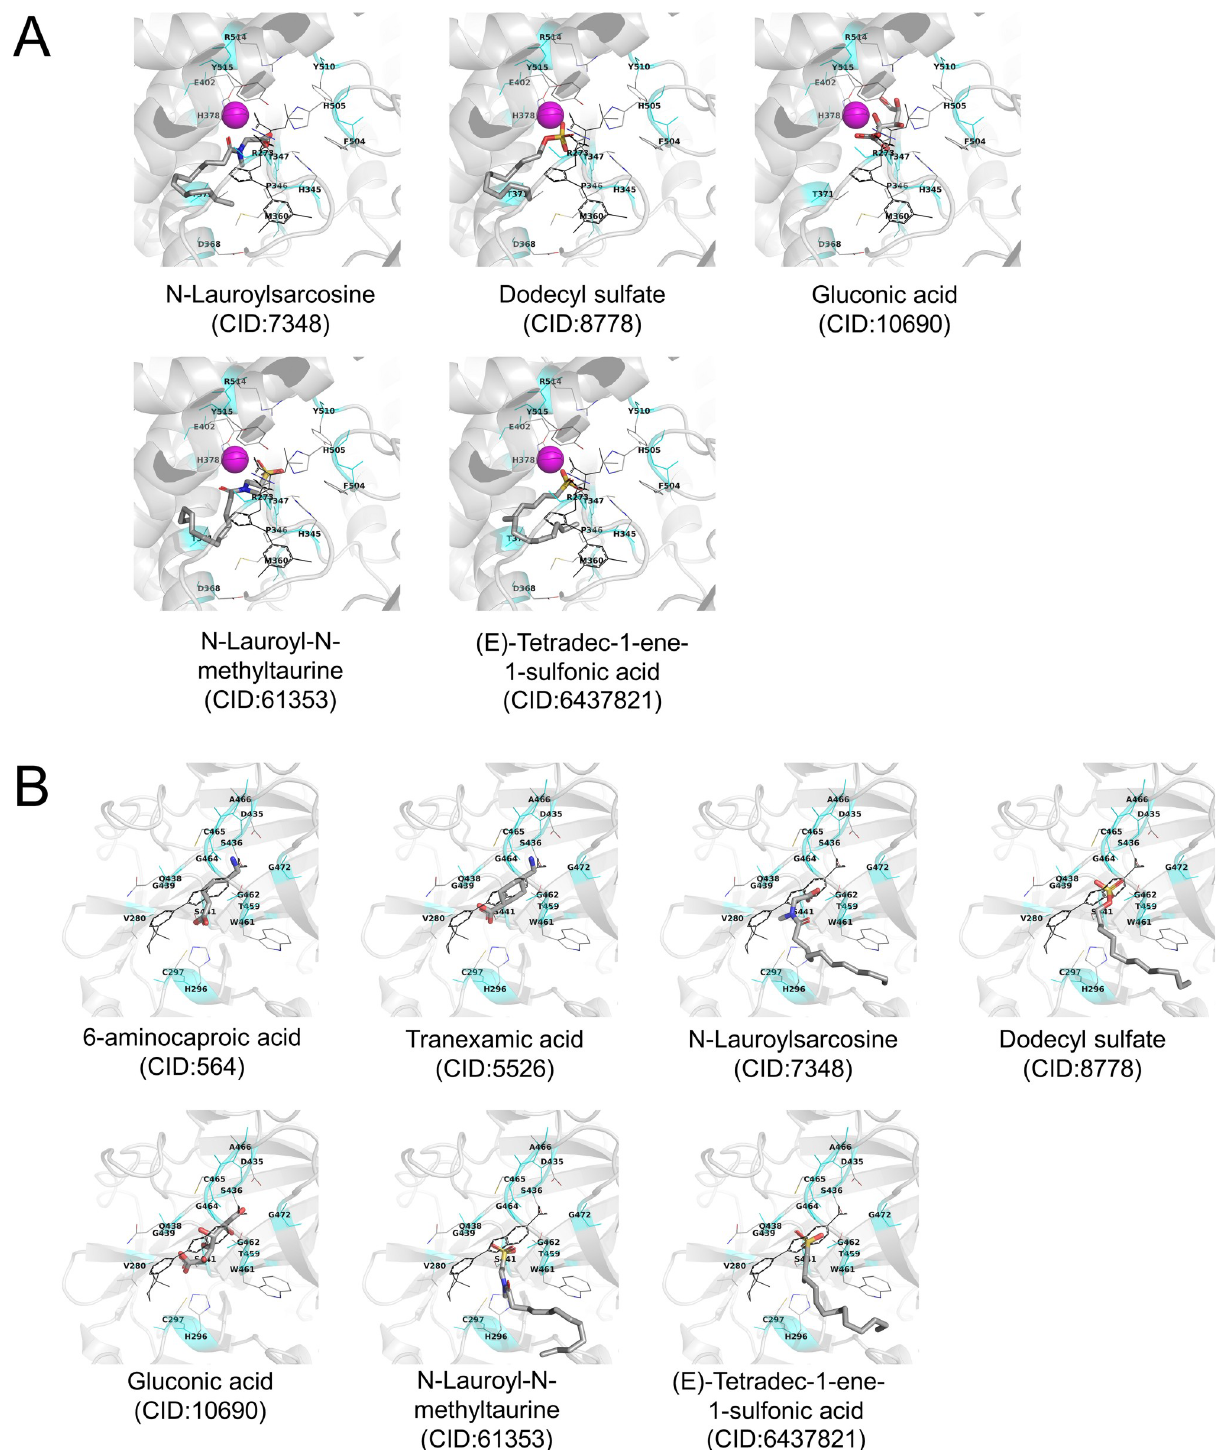
Fig 6. Stable docking mode of the selected ingredients obtained from AutoDock Vina docking simulations. (A) Human ACE2. (B) Human TMPRSS2 model. Stable docking mode of test compounds is shown as CPK-colored tubes. The original crystal structure of the inhibitor is shown in black lines. A magenta sphere shows Zn 2+ ion. Inhibitor-binding site located at 3 Å from all heavy atoms of the crystal inhibitor is shown in cyan color. Amino acid residues located at 3 Å from the inhibitor are shown using thin tubes with label. Hydrogen atoms are neglected.